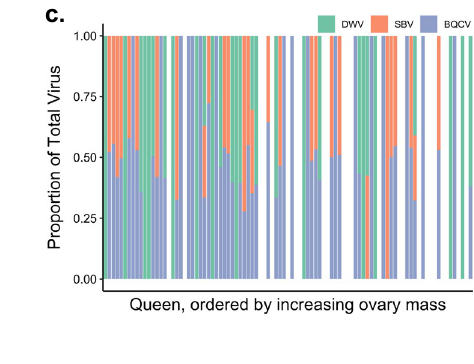
log10(viral RNA copies +1) per microgram RNA